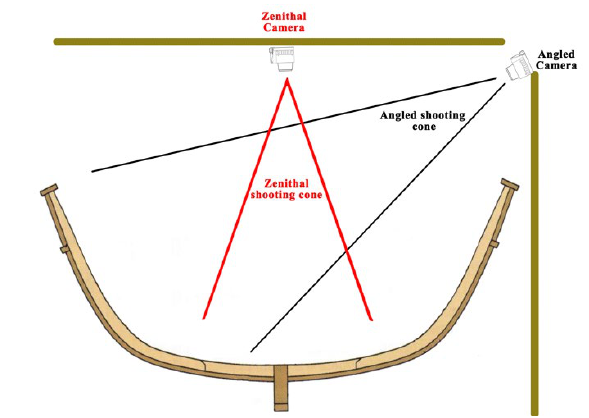
Figure 3. Simplified scheme of the shooting cones for the different acquisition methods.